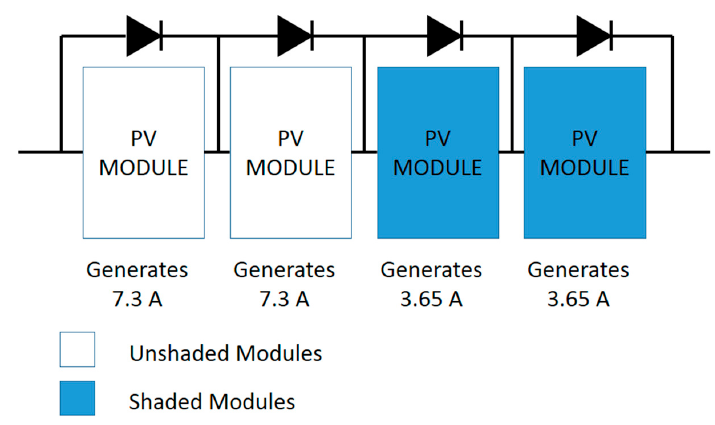
Figure 14. Photovoltaic string consisting of four photovoltaic modules.